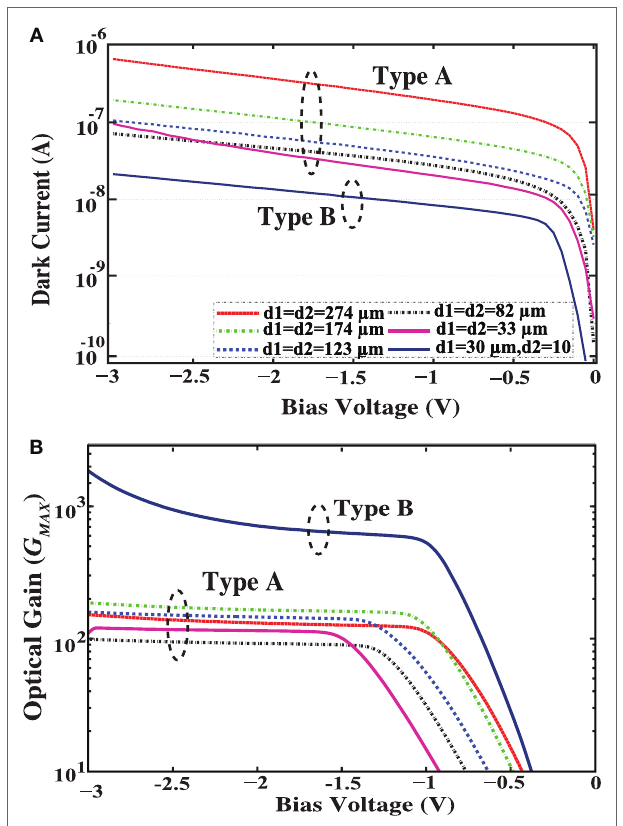
FiGURe 15 | (A) Measured electron-injection detector dark current versus bias voltage characteristic. Data were obtained by averaging over 10 detectors per device size. (B) Measured optical gain ( G MAX ) versus bias voltage characteristic. Color-coding for part (A,B) is the same. Reproduced with permission from Fathipour et al. (2015). Copyright 2015 AIP Publishing LLC.